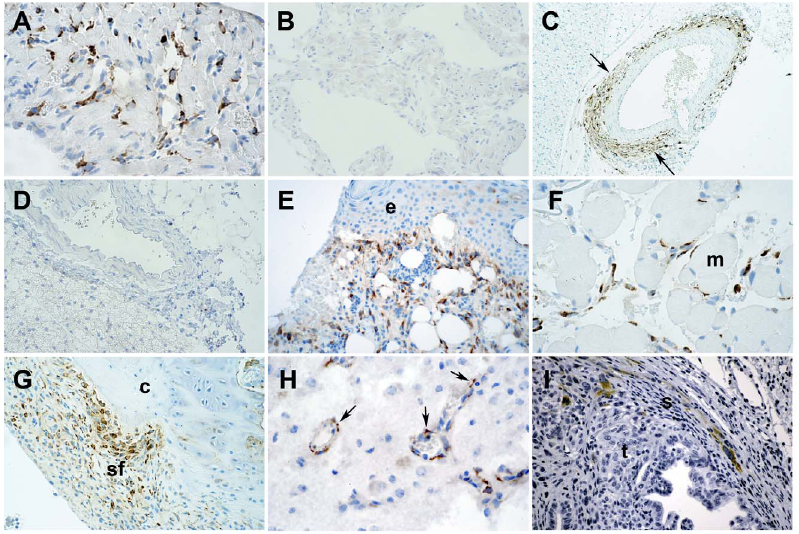
Figure 2. Immunolocalization of Cthrc1 in various remodeling mouse tissues. Immunohistochemistry was performed using rabbit monoclonal antibody Vli-55. (A) In response to angiotensin II, Cthrc1 is induced in interstitial myocardial cells of wildtype mice, but no expression is detected in similarly treated Cthrc1 null mice (B). (C) Angiotensin II-induced Cthrc1 in outer mural cells of the renal artery of wildtype mice (arrows) but not Cthrc1 null mice (D). (E) A skin incisional wound with Cthrc1 localization in activated dermal cells but not in the epidermis (e). (F) Ischemic muscle injury led to Cthrc1 protein expression in interstitial cells but not myocytes (m). (G) An arthritic joint with Cthrc1 in activated synovial fibroblasts (sf) but not in chondrocytes (c) is shown. (H) Remodeling tumor vessels of a germ cell tumor reveal Cthrc1 in outer mural cells (arrows), and (I) pancreatic ductal cancer shows Cthrc1 in cells of the surrounding stroma (s) but not in the tumor cells (t). Cthrc1 immunoreactivity in brown with hematoxylin counterstain. Original magnification 100x (C), 200x (B, D, E, G, I), and 400x (A, F, H). doi:10.1371/journal.pone.0100449.g002 LC Biotin, G-Biosciences) were used as detection antibodies for mapped to the N terminal half of the molecule. This included human and rodent Cthrc1, respectively. It is important to note Cthrc1 with C terminal myc tag, myc/6xHis tag, 8xHis tag, or that none of the monoclonal antibodies generated recognized C Cthrc1 with deletion of the C terminal lysine (K) residue. terminally modified Cthrc1 by ELISA, even though their epitopes